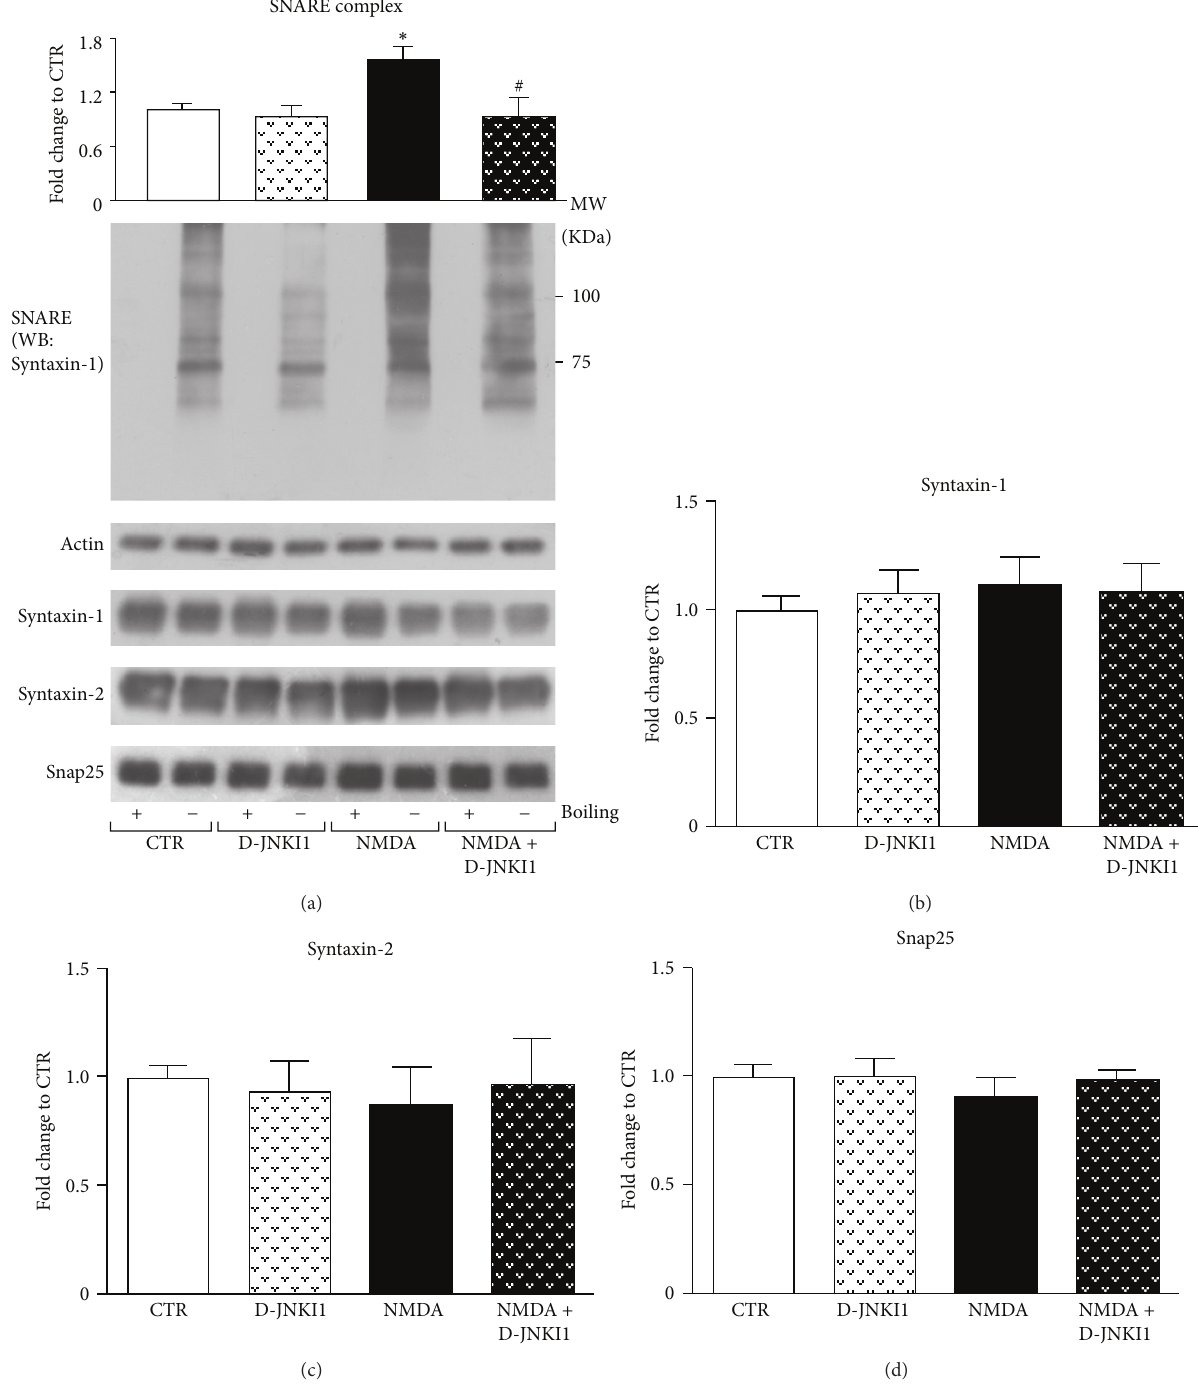
Figure 7: JNK inhibition reduces SNARE complex formation. (a) Western blotting and relative quantification of SNARE complex levels (anti-Syntaxin-1 immunoreactive bands from approximately 75 to 100KDa) in 20 𝜇 g of crude synaptosomes stimulated with NMDA 100 𝜇 m and glycine 1 𝜇 m for 7 min in presence or absence of D-JNKI1 (2 𝜇 m), added to synaptosomes 25 min before stimulation. After NMDA/Gly exposure there was a significant increase in SNARE complexes formation ( ∗ 𝑝 < 0.05 ), which is totally prevented by D-JNKI1 preadministration ( # 𝑝 < 0.05 ). SNARE complexes are normalized on actin, 𝑁 = 6 . Data are shown as mean ± SEM, Two-way ANOVA, Tukey's post hoc test. (b–d) Western blotting and relative quantification of Syntaxin-1, Syntaxin-2, and Snap25 in 20 𝜇 g of crude synaptosomes stimulated with NMDA 100 𝜇 m and glycine 1 𝜇 m for 7 min in presence or absence of D-JNKI1 (2 𝜇 m), added to synaptosomes 25 min before stimulation. There was no significant variation of protein levels after NMDA/Gly exposure as well as after D-JNKI1 administration alone or in combination with NMDA/Gly. Proteins are normalized on actin, 𝑁 = 6 . Two-way ANOVA, Tukey’s post hoc test. Data are shown as mean ±